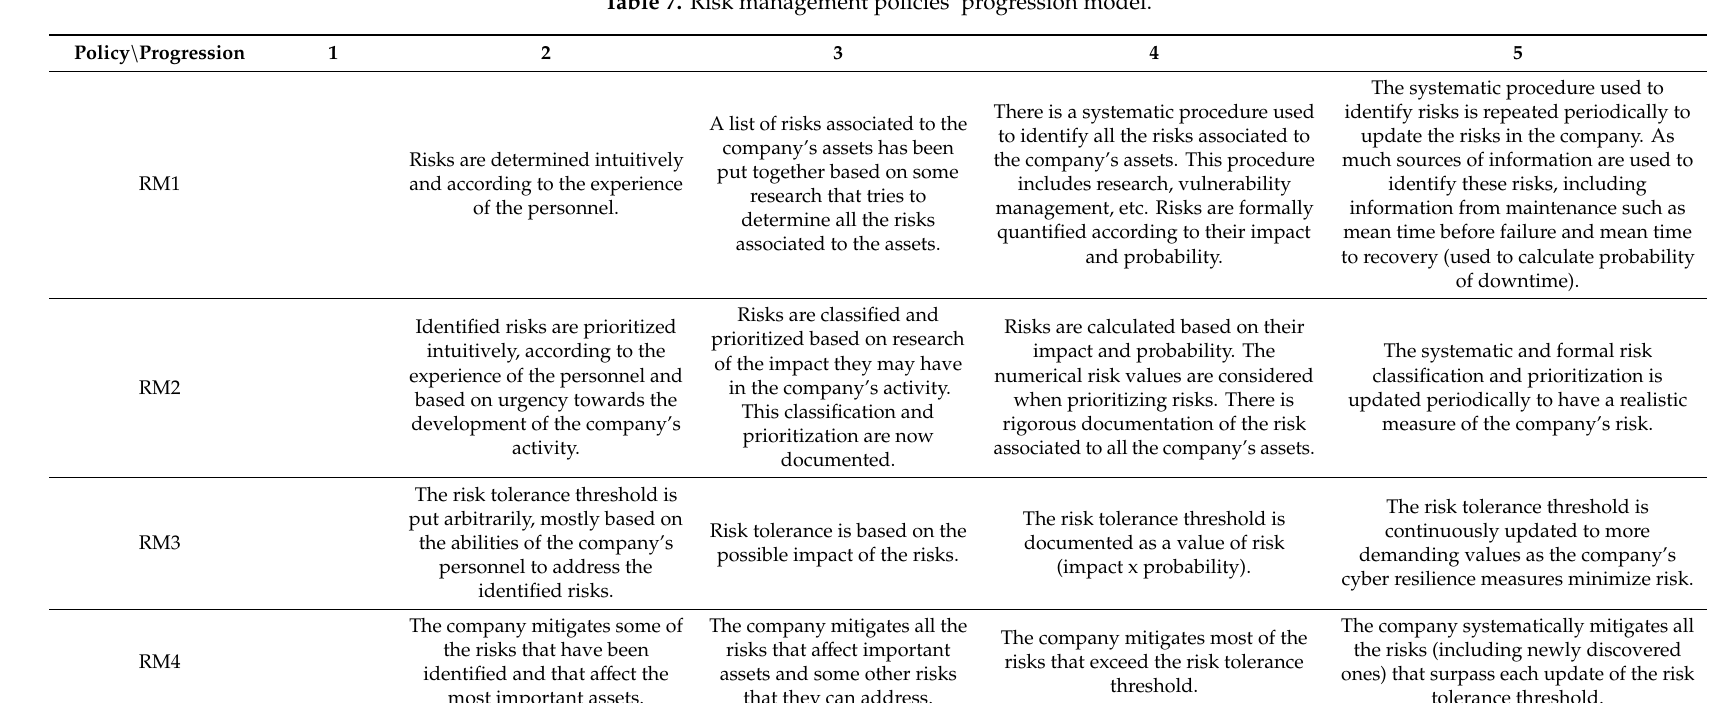
Table 7. Risk management policies’ progression